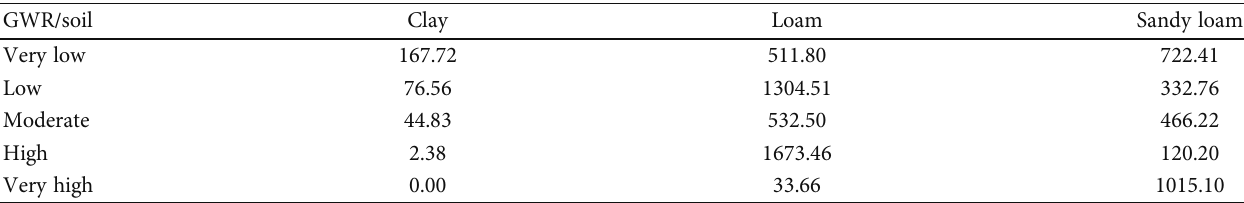
Table 14: Cross-tabulation between GWR and soil.